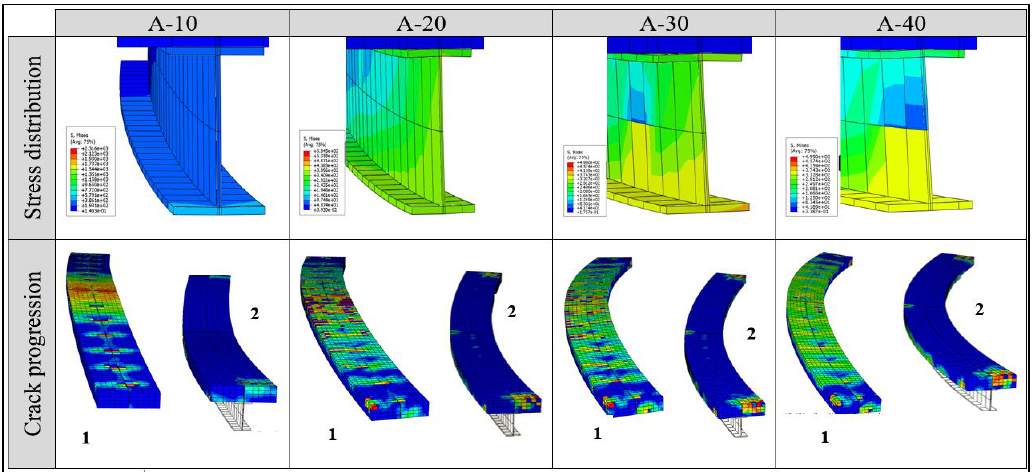
Figure 12. Effect of span/radius ratio on: (a) Stress distribution; (b) Crack progression on the slab, 1- Top surface of the beam, 2- Bottom surface of the concrete